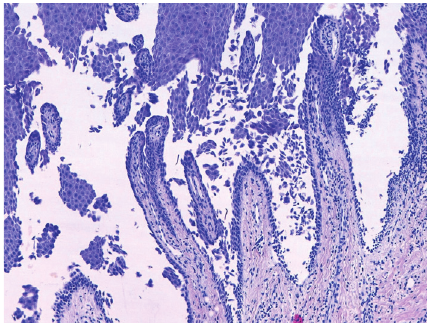
Figure 2: Suprabasal acantholytic and dyskeratotic keratinocytes (H-E ×